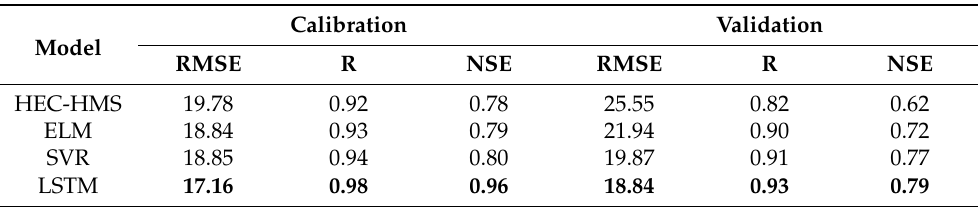
Table 3. Statistical measures of streamflow simulation during the calibration and validation phases at the daily scale. The bold values represent the best statistics among all the models. Model